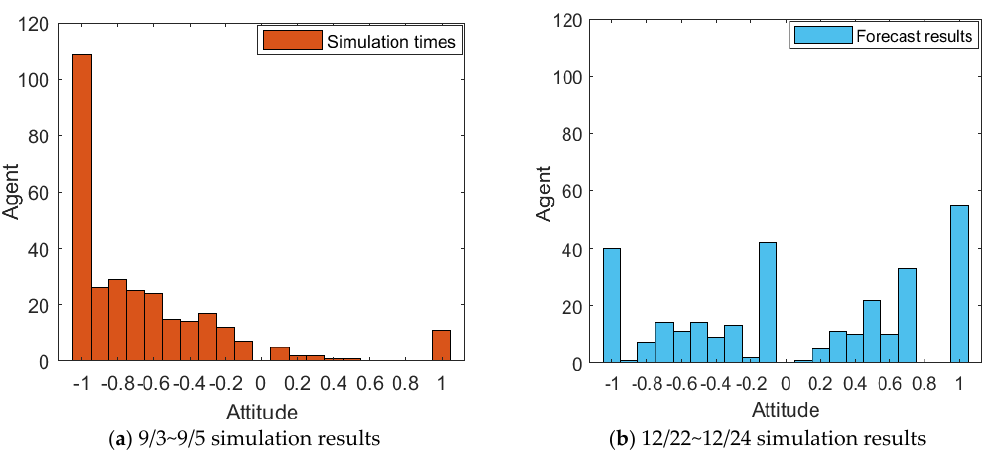
Figure 32. Simulated group attitude distribution histogram. ( a ) 9/3~9/5 simulation results; ( b ) 12/22~12/24 simulation results.